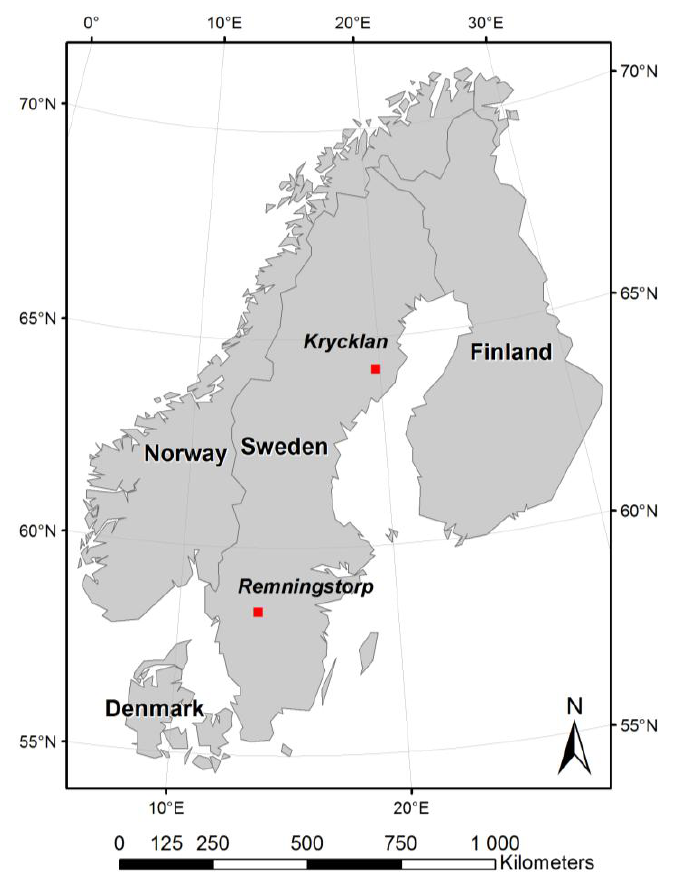
Figure 1. The two test sites Krycklan and Remningstorp, located in northern (64°N) and southern (58°N) Sweden,